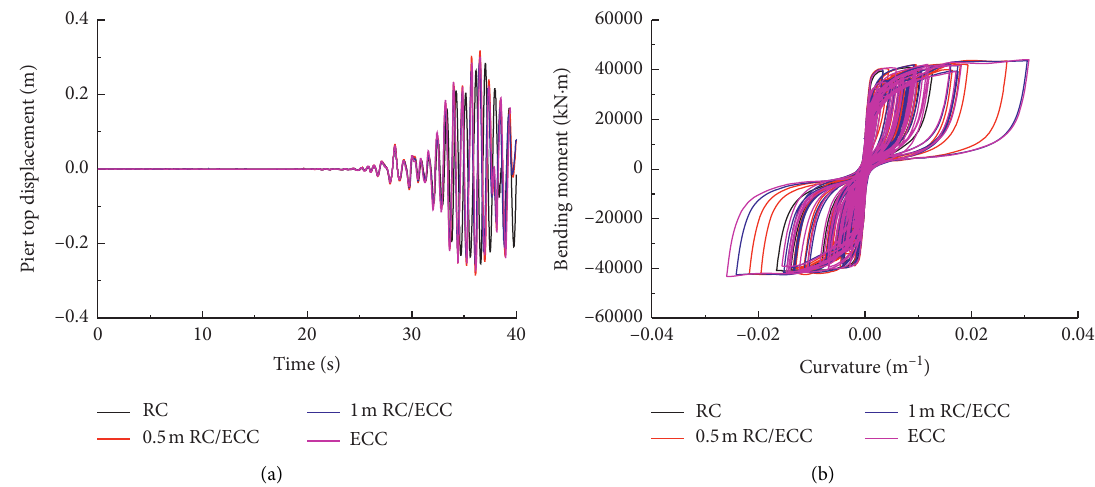
Figure 4: Seismic response of the piers: (a) time-history curve of pier top displacement and (b) moment-curvature hysteretic